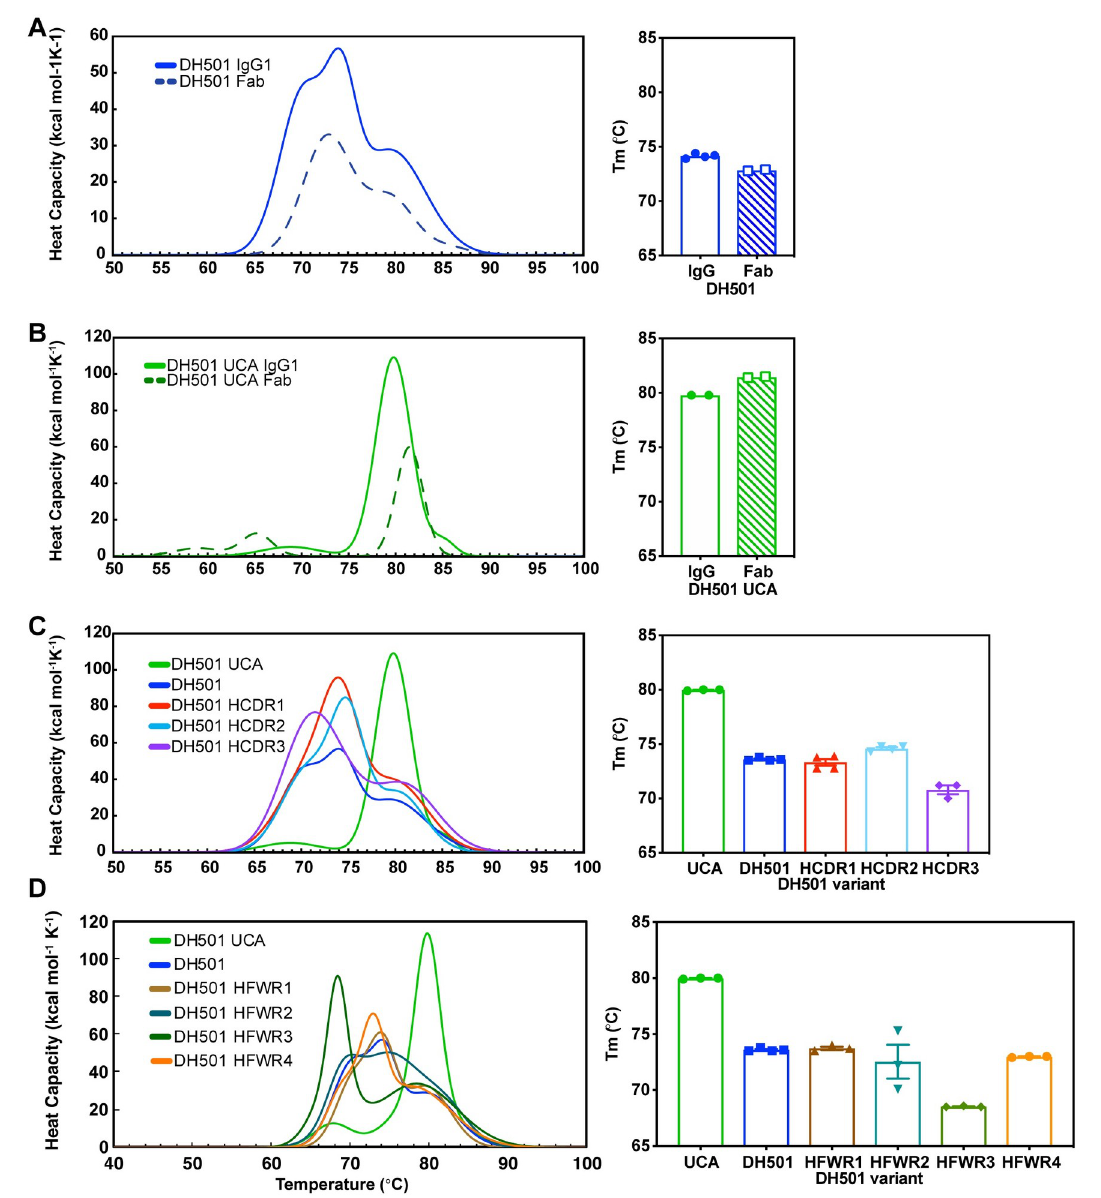
(left) show the melting transitions and the Tm for IgG and Fab is shown in the bar graph (right). The bar graph symbols represent the independent measurements with the bar showing the mean of the replicates. (C,D) The melting curves and Tm of ( C ) HCDR-reverted and ( D ) HFWR-reverted DH501 IgG antibodies. The bar graph symbols represent independent measurements with the bar showing the mean of the replicates.